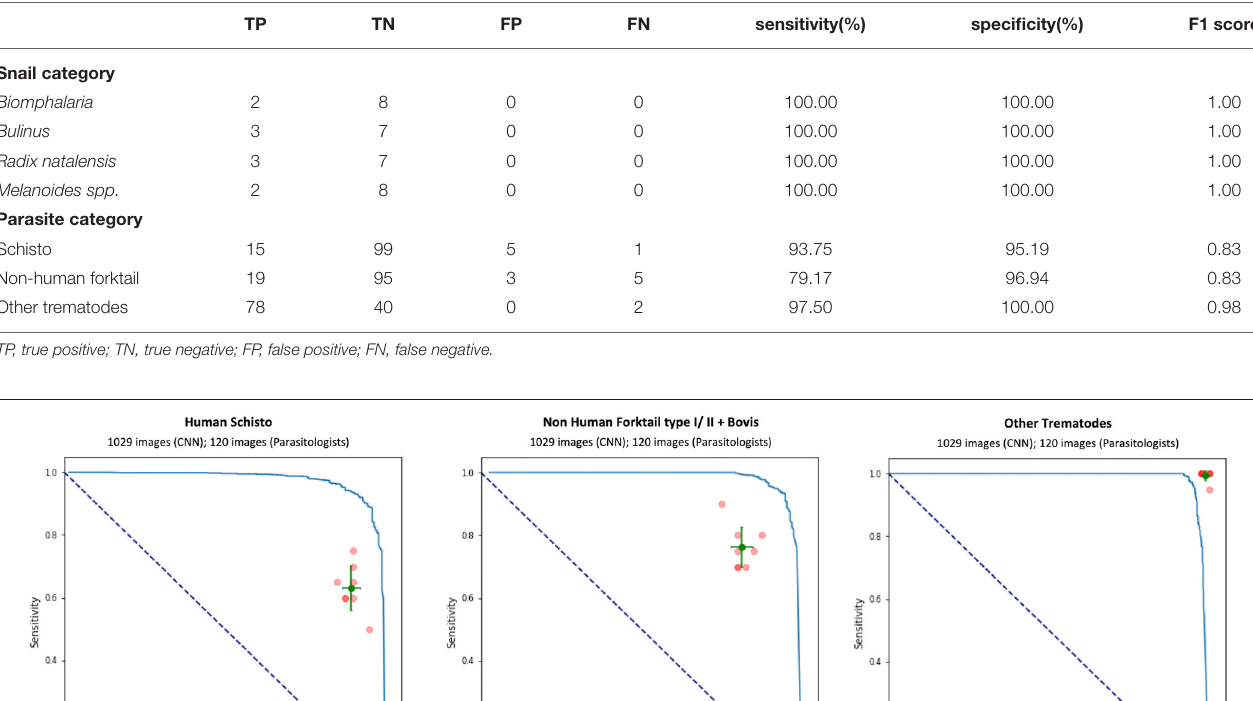
TABLE 3 | Results of the identification of snails and cercaria by eight parasitologists.